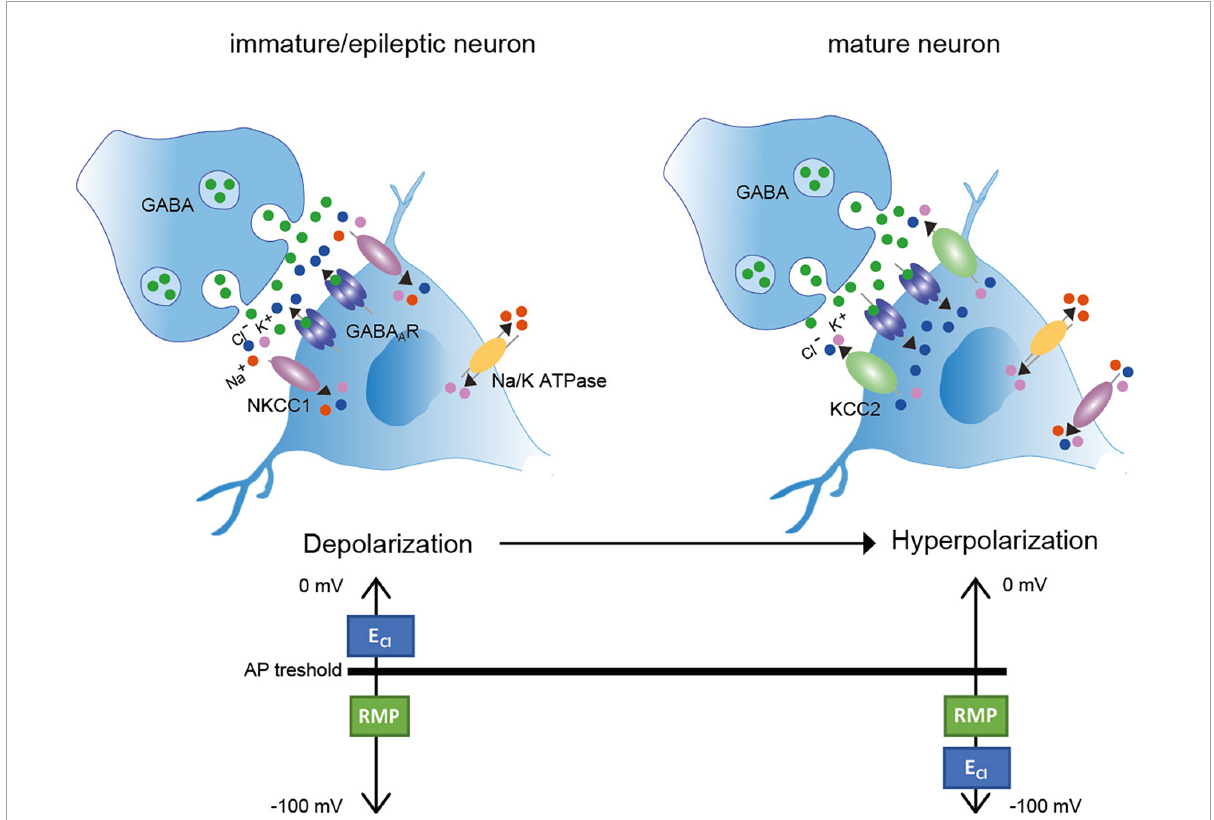
FIGURE1 Depolarization/Hyperpolarization shift in inhibitory neurons (Left). In immature neurons, high transport activity of NKCC1 results in increased [Cl – ] i . Binding of the inhibitory neurotransmitter GABA to GABA A receptors results in Cl – outward currents and thus depolarization. Here, the E Cl − is more depolarized than the AP threshold (Right). In mature neurons, KCC2 activity is increased resulting in decreased [Cl – ] i . Binding of the inhibitory neurotransmitter GABA to its receptor results in Cl – inward currents and thus hyperpolarization. E Cl − is here hyperpolarized according to the resting membrane potential. AP: action potential; RMP: resting membrane potential. Green dots: GABA; red dots: Na + ; purple dots: K + ; blue dots: Cl – . Figure modified from Moore et al.